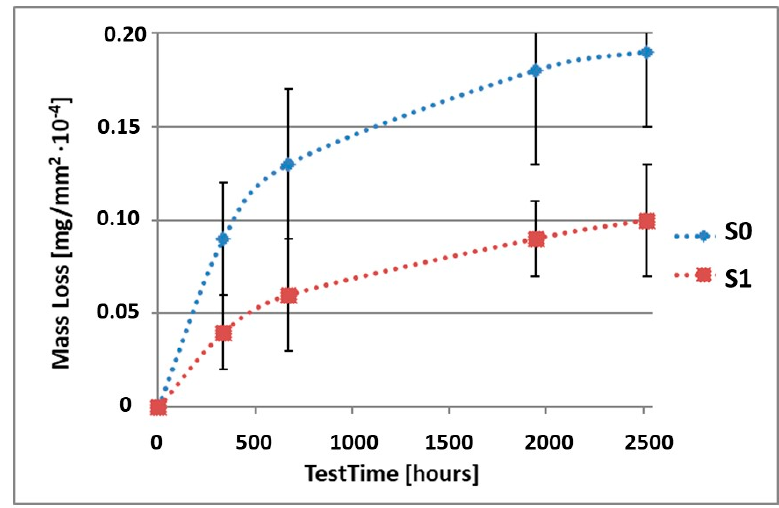
Figure 6. Comparison of the mass losses of samples S0 and S1 for tests in CASS environment.